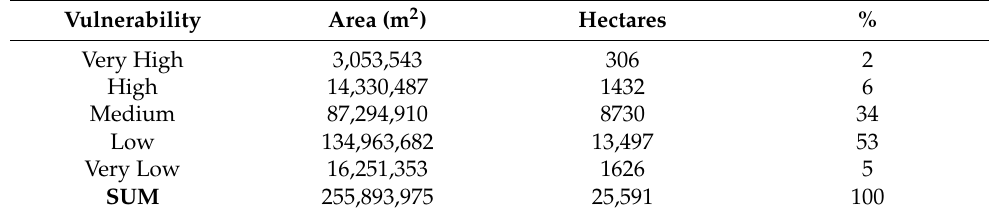
Table 7. Earthquake vulnerability in Tabriz, Iran, according to the MLP algorithm.